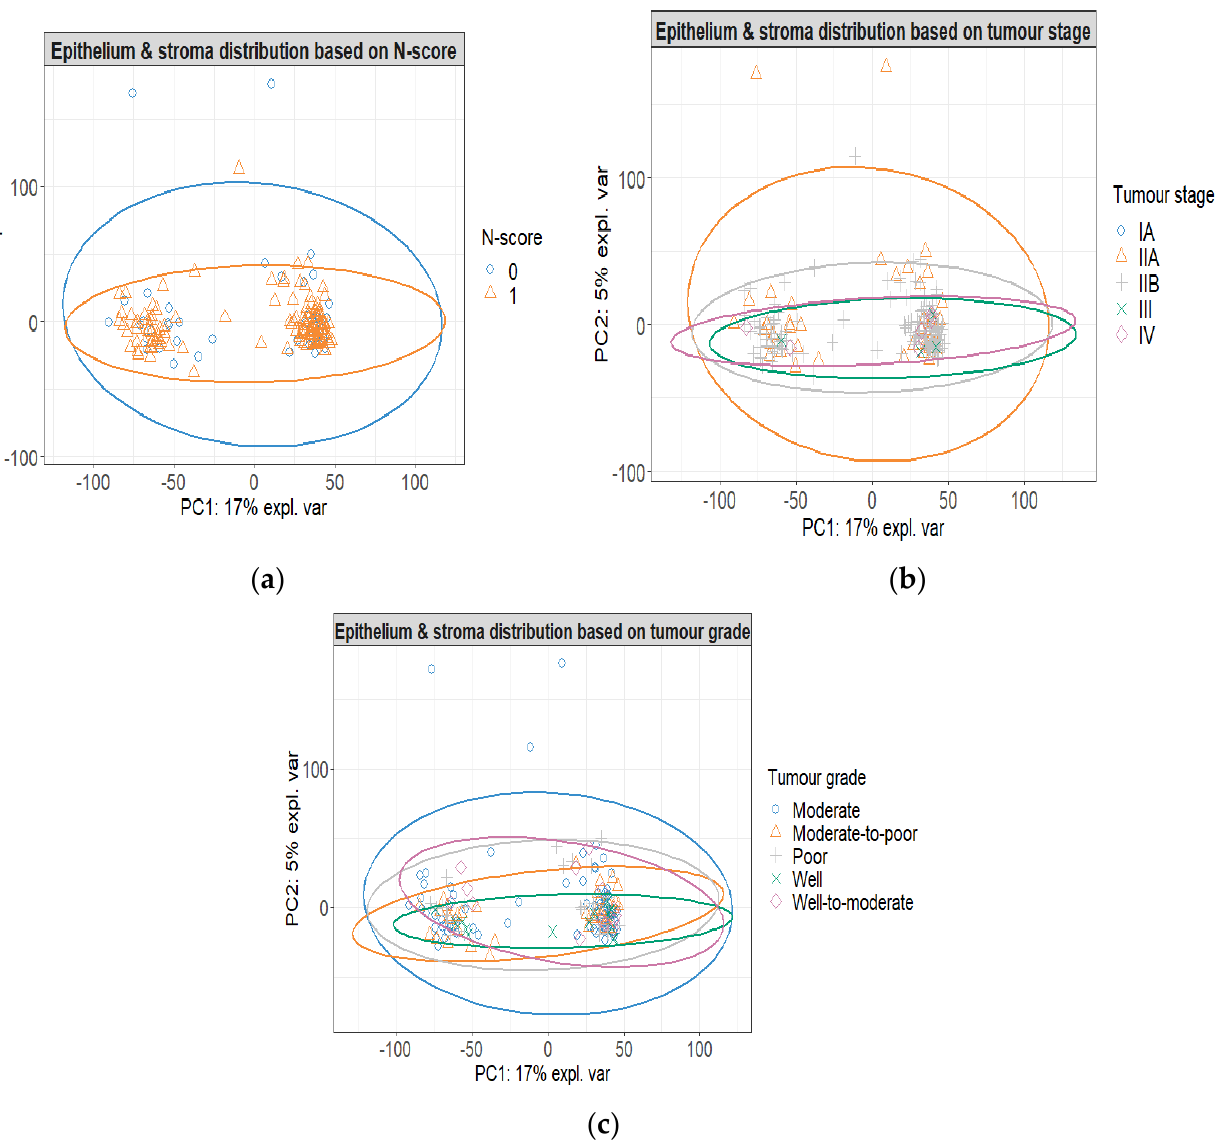
Figure A4. Unsupervised segregation of 187 samples with available metadata (65 epithelium and 122 stroma) from the GSE93326 dataset using Principal Component Analysis. Segregation of the samples was performed based on ( a ) tumour N-score ( n = 177), ( b ) overall tumour stage ( n = 187), and ( c ) tumour grade ( n = 187). N-scores: 0 and 1 indicate no spread to nearby lymph nodes and spread to no more than three nearby lymph nodes, respectively.